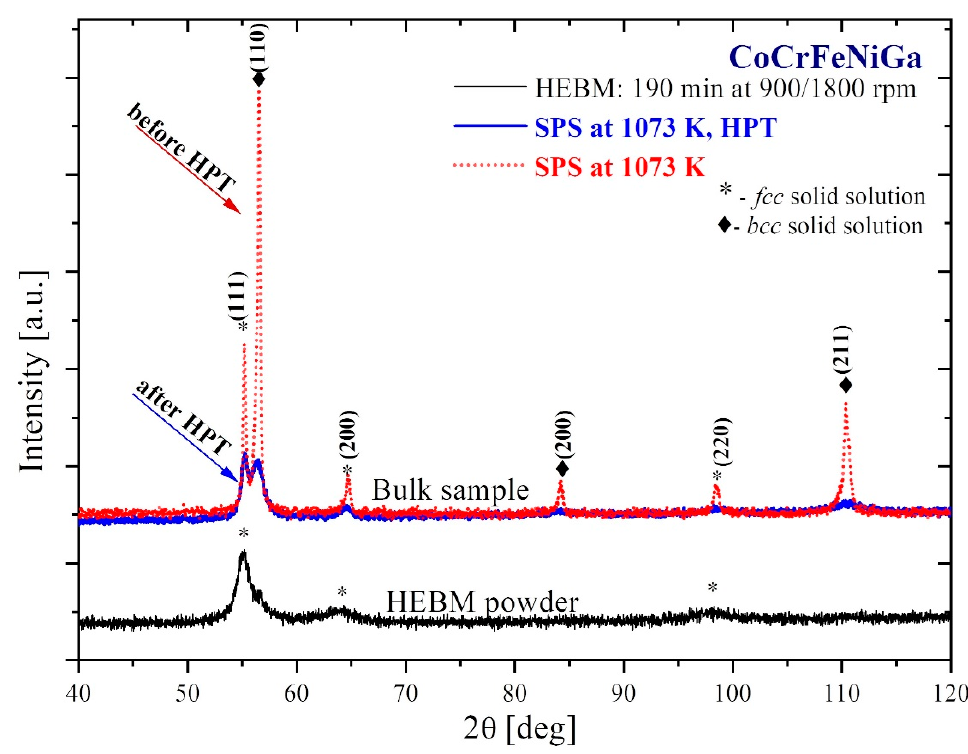
Figure 4. XRD patterns of the CoCrFeNiGa HEBM-processed powder (black), SPS-consolidated (dash red), and HPT-deformed (blue) samples. red), and HPT-deformed (blue)